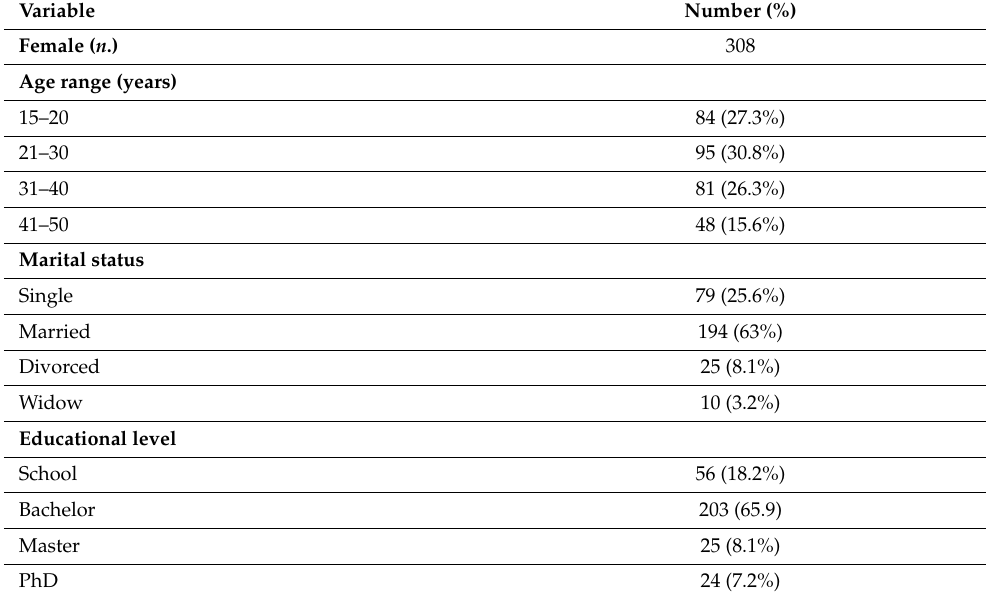
Table 1. Demographic